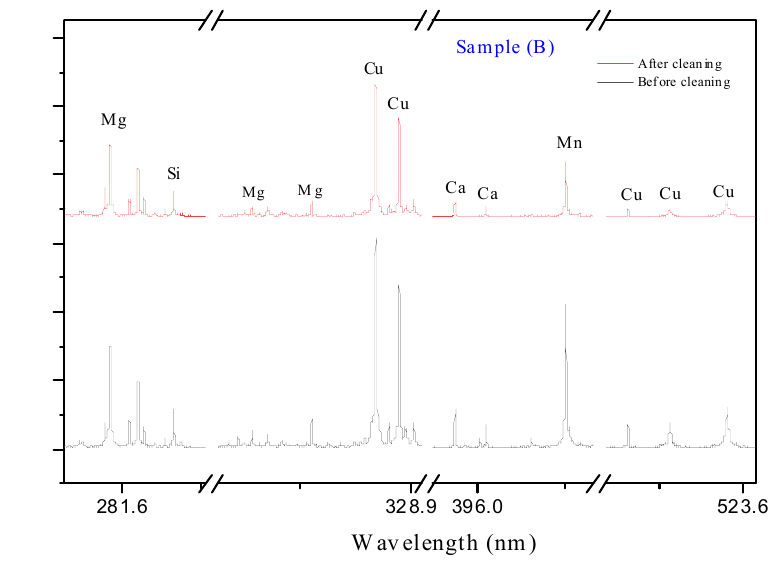
Figure 6. The LIBS spectra of the corroded coin sample (B) before and after cleaning.